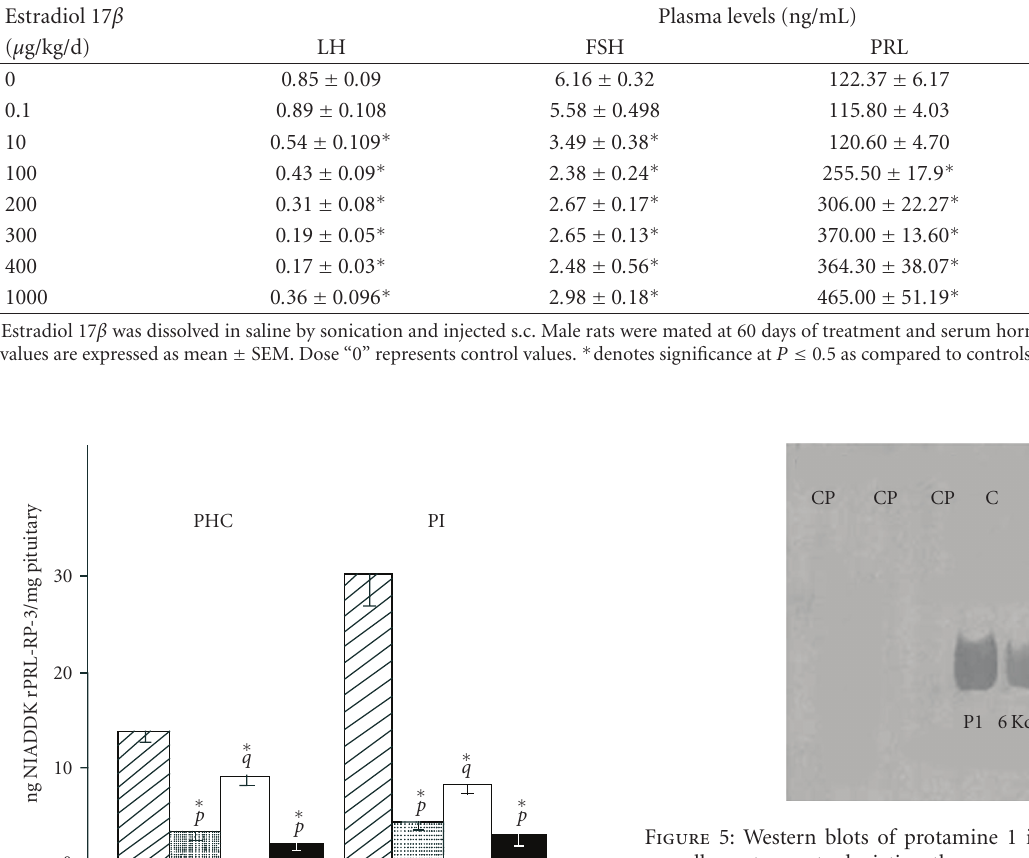
Table 3: E ff ects of estradiol 17 β on serum hormones in adult male rat.